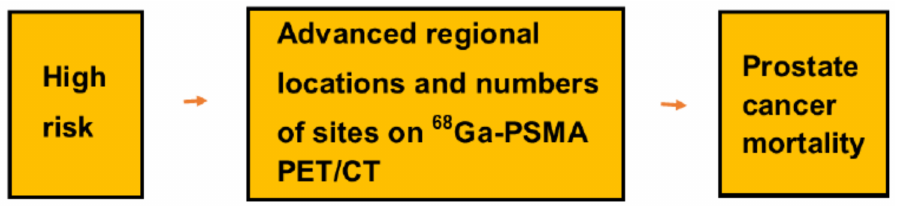
Figure 3. This figure summarizes the study in showing that the initial risk score and the regional locations and number of positive sites on 68 Ga-PSMA-PET/CT scans predicted overall